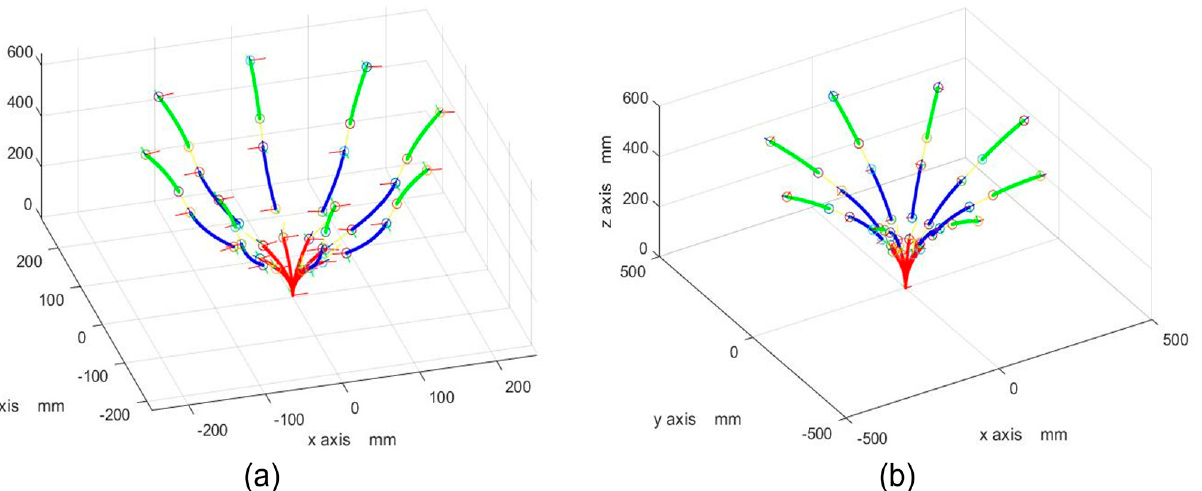
Figure 13. Kinematic simulation of the flexible manipulator: ( a ) change in the arc curvature 𝜅 of the second segment, ( b ) change in the arc curvature 𝜅 of the third segment. The last is the simulation of velocity kinematics, as shown in Figure 14. Given an initial posture of the flexible manipulator, the first segment arc parameter (𝜅, 𝜑, 𝑙) is (0.003, 0, 170) , the second segment arc parameter (𝜅, 𝜑, 𝑙) is (0.002, 𝜋 ⁄ 2, 170) , and the third segment arc parameter (𝜅, 𝜑, 𝑙) is (0.001, 𝜋 ⁄ 2, 170) . The kinematics are simulated by substituting different end velocities and directions in the kinematics. Finally, the kine- matics have been verified for feasibility.